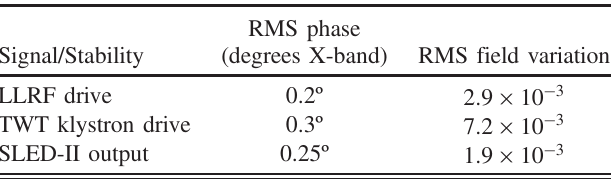
TABLE I. rf phase and amplitude jitter measurements.